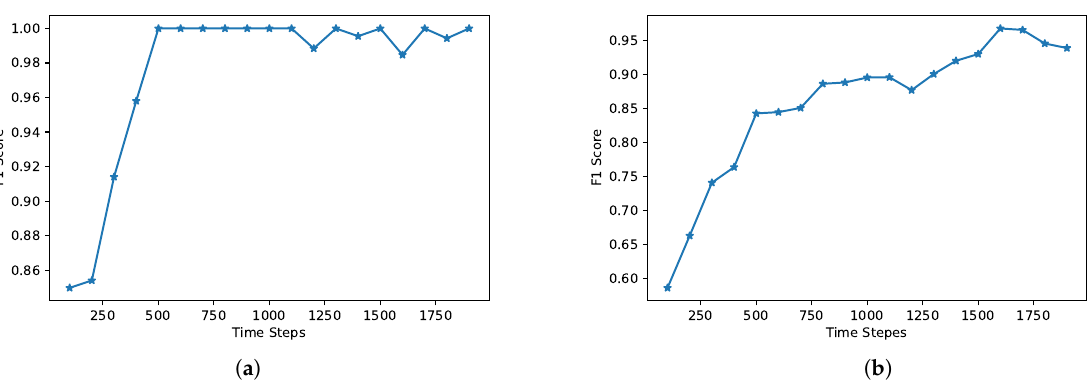
Figure 13. Five-runs accuracy performance (F1 score) vs. time steps used for a single point: ( a ) Dataset 1; ( b ) Dataset 2.